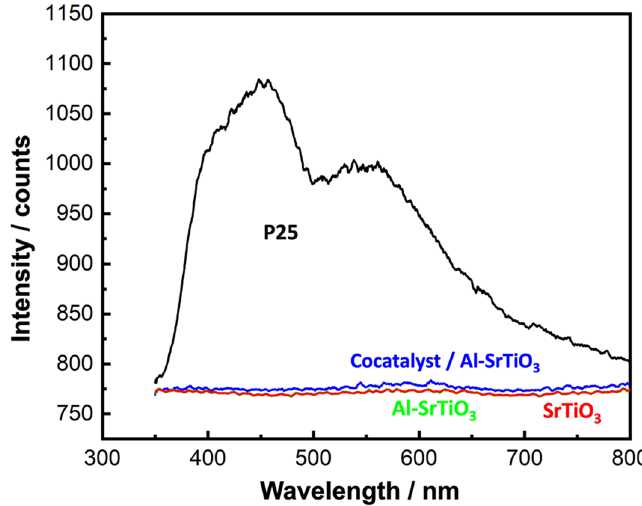
Figure 3. PL analysis of the investigated